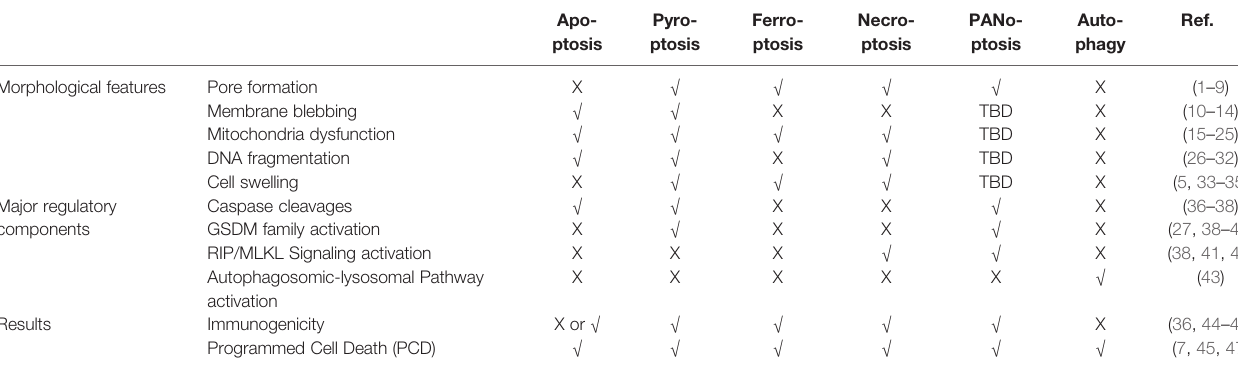
TABLE 1 | Summary of key features of